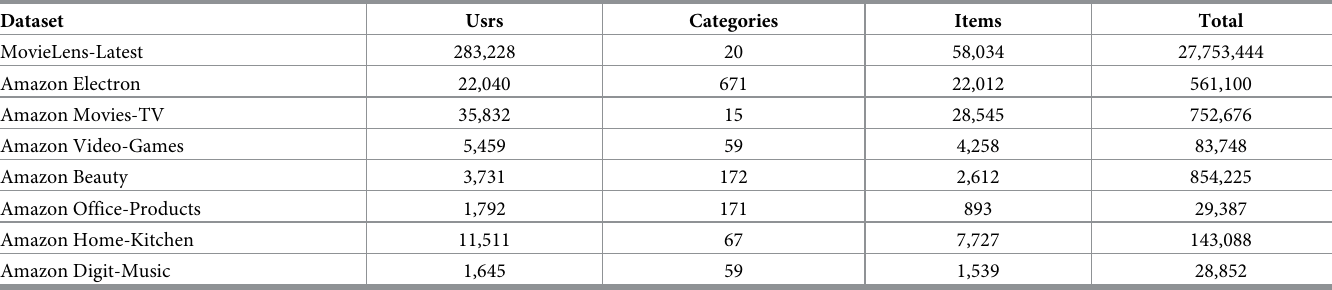
Table 2. Statistics of the two datasets for offline